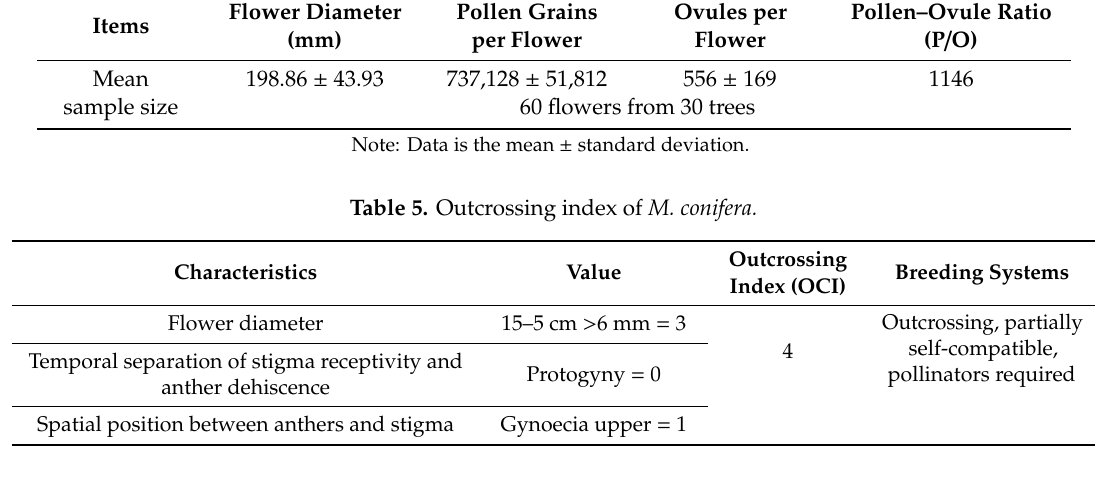
Table 4. Floral characteristics of M. conifera.